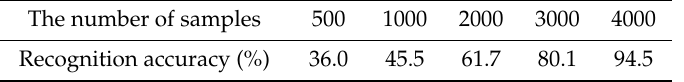
Table 1. The recognition accuracy corresponding to di ff erent numbers of training samples (SNR = 10 dB). The number of